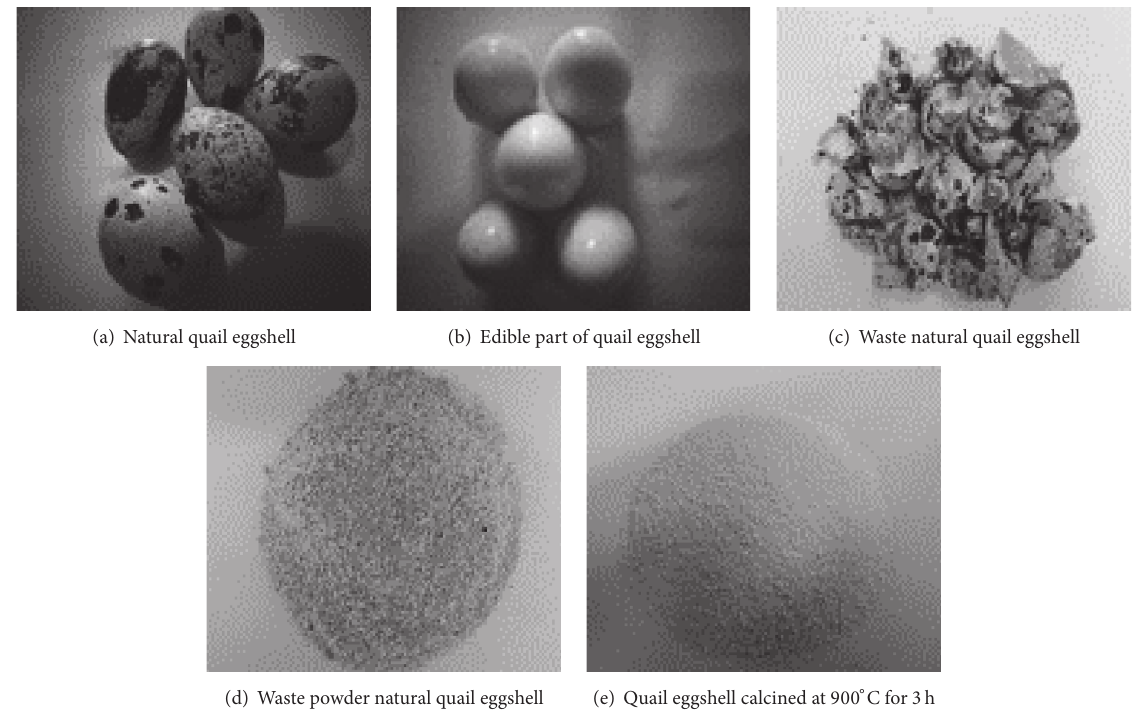
Figure 1: Method of obtaining the CaO from natural quail